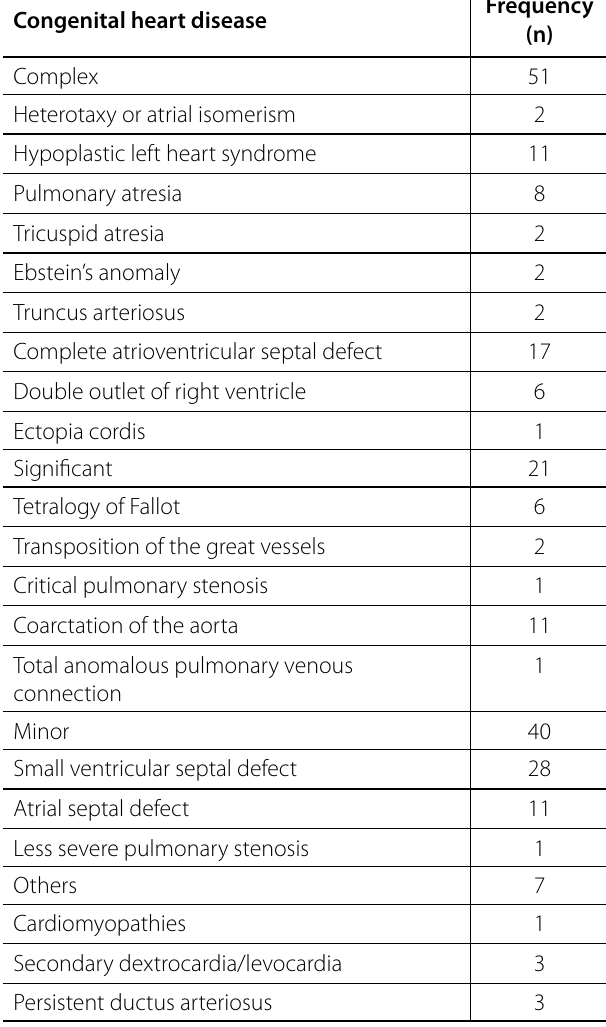
Table 2 . Congenital heart disease by the classification system according to the complexity of anatomical heart abnormalities (n=119).